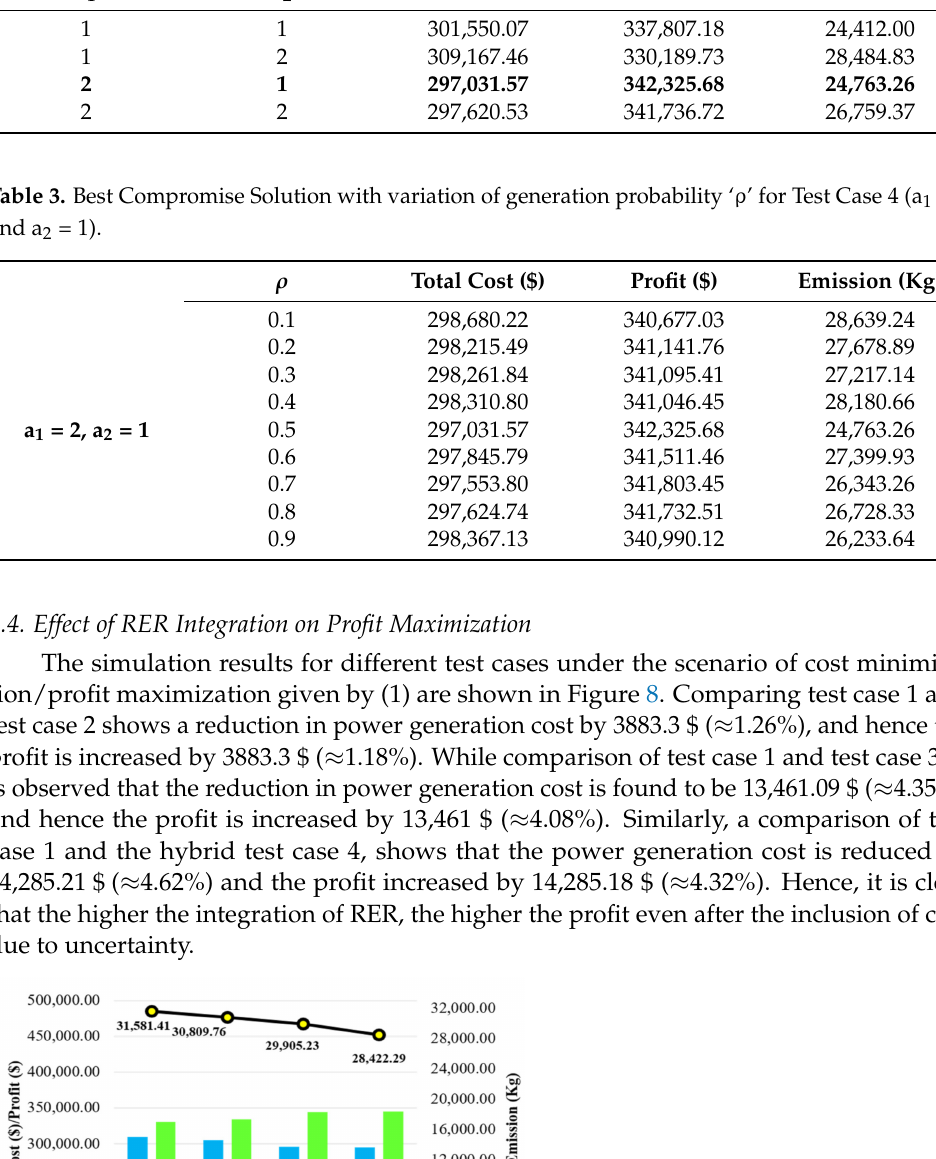
Table 2. Best Compromise Solution with the variation of parameters a 1 , a 2 for Test Case 4 ( ρ = 0.5). Parameters Total Cost ($) Profit ($)